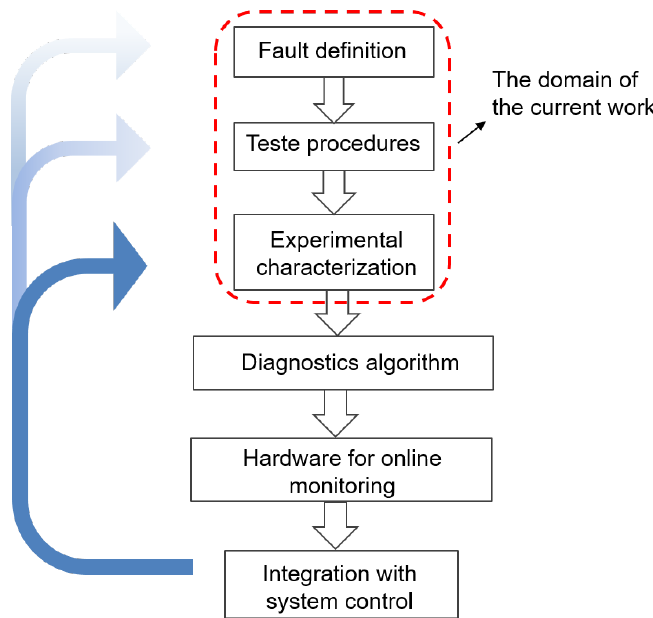
Figure 1. The domain of the current work on the diagnostic tool development process.